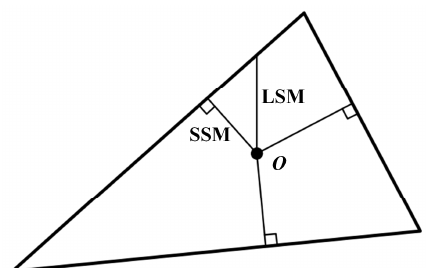
Figure 5. Schematic diagram of SSM and LSM.